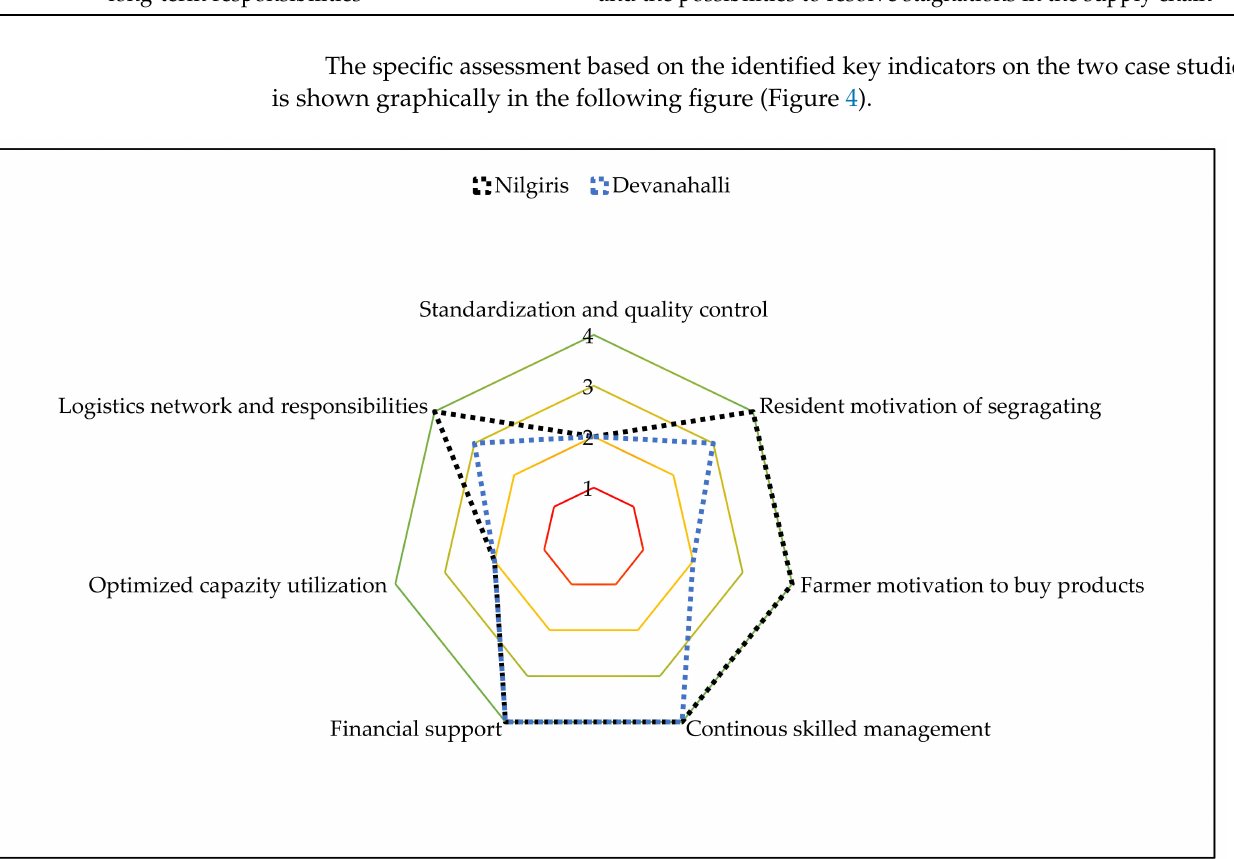
Figure 4. Evaluation of two case studies, based on the identified criteria and the assessment of the stakeholders (1 = insufficient; 2 = satisfactory; 3 = good; 4 = very